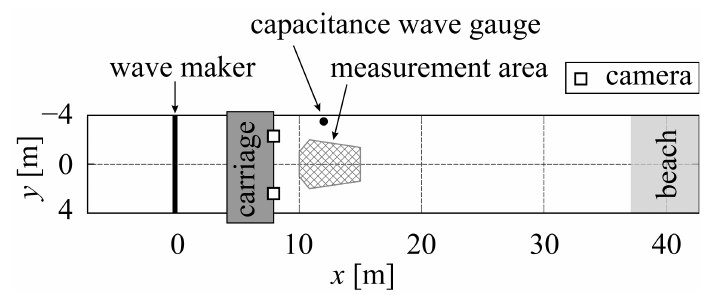
Figure 2. Schematic of the stereo camera set up in the wave tank